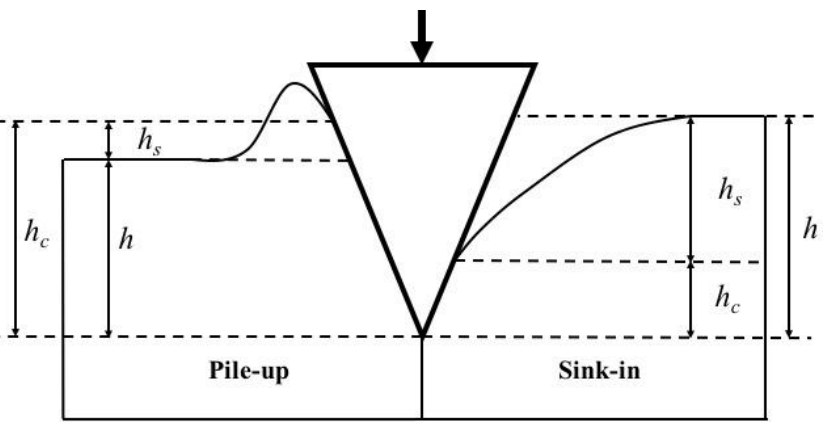
Figure 1. Indentation geometry showing the pile-up and sink-in. The mathematical expressions followed for the calculation of the projected contact area of the nanoindenter are presented in Equation (3) for the case study of a Berkovich indenter’s tip [ 62], and in Equation (4) for the case study of the spherical indente r’s tip: 𝐴 = 24,5ℎ 𝑐2 + 𝐶ℎ 𝑐 , (3) 𝐴 = 𝜋(2𝑅ℎ 𝑐 − ℎ 𝑐2 ) ,